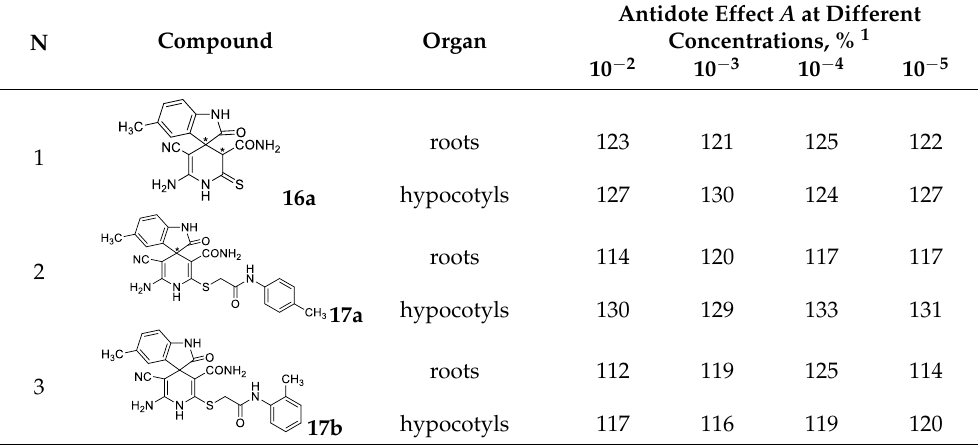
Table 3. The antidote effects of the most active compounds 16a and 17a,b with respect to herbicide 2,4-D. N N Compound Organ